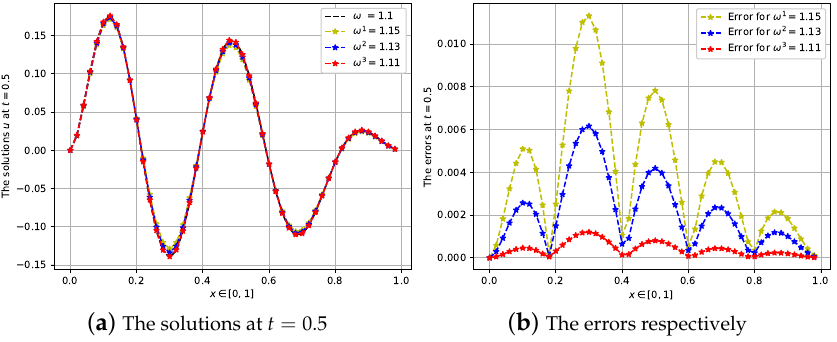
Figure 3. The solution u for ω = 1.1, ω i ∈ { 1.15,1.13,1.11 } at t = 0.5 and the respective error.